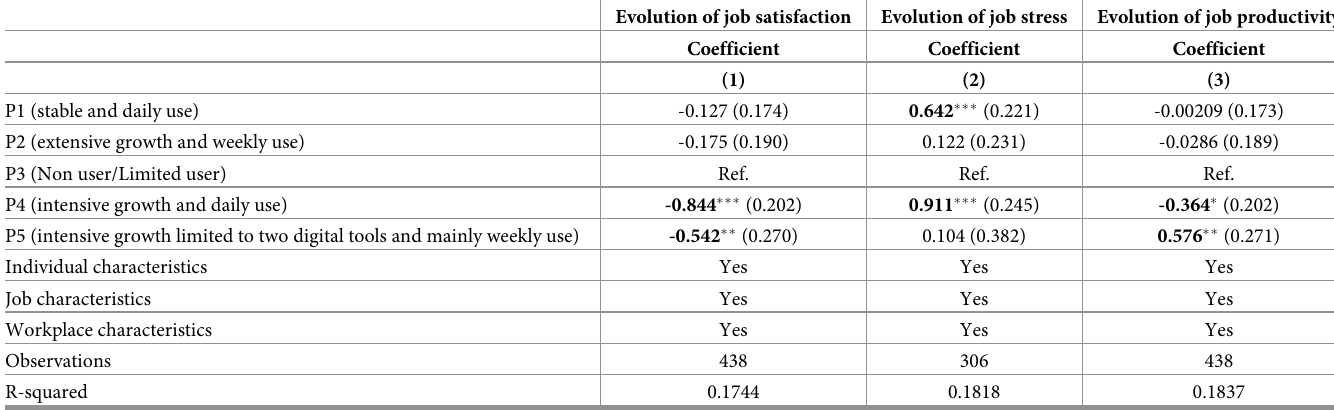
Table 3. Collaborative and communication digital profiles and the evolution of subjective well-being and job productivity before and during the lockdown (ordered probit